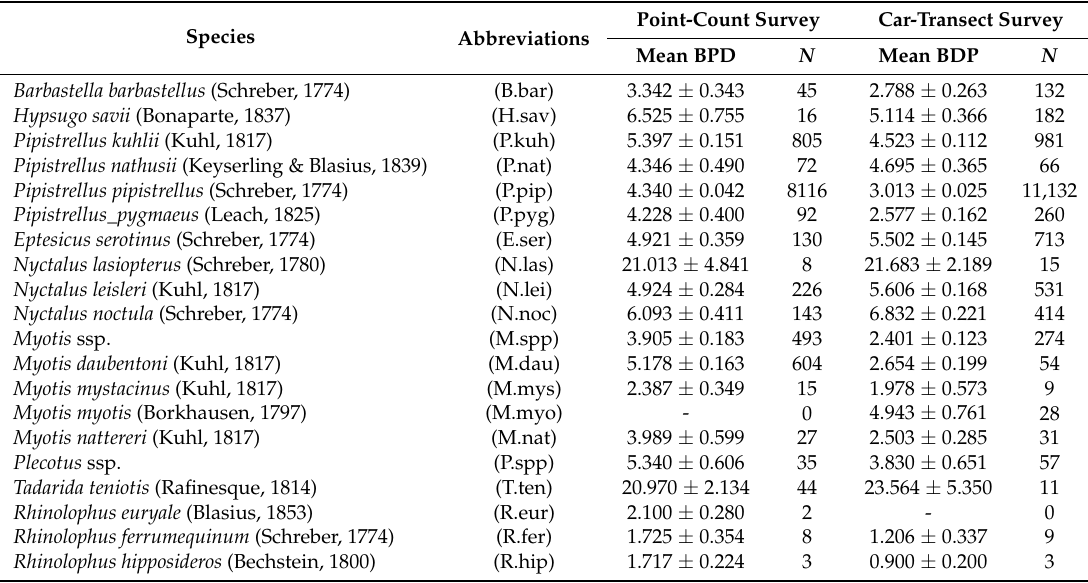
Figure 3. Relationship between bat-pass duration and detection distance [3] for ( a ) the car-transect survey ( b ) and the point-count survey. For species abbreviations, see Table 1. Table 1. Means of bat-pass duration (BPD) expressed in seconds ± SE and number of bats call recorded (N) according to type of survey.